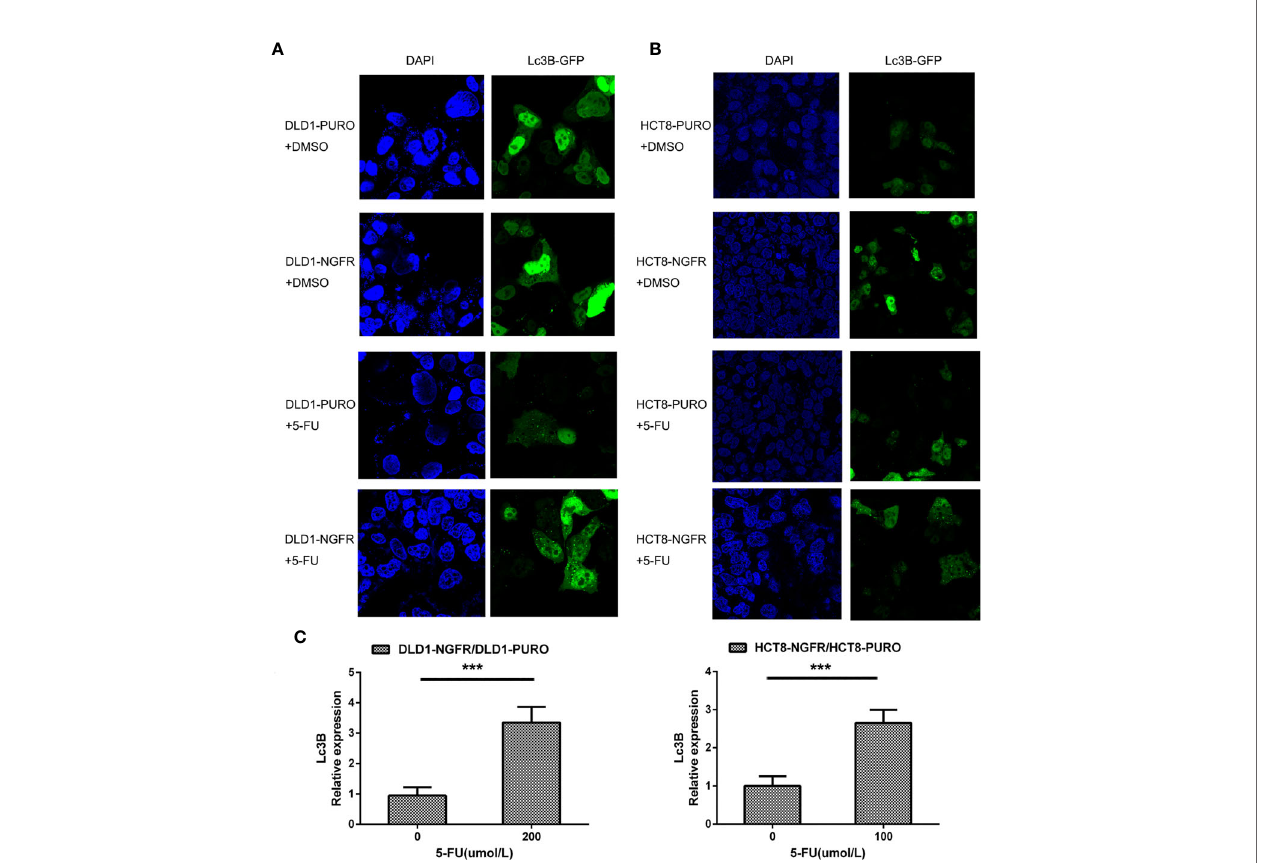
FIGURE 3 | NGFR promoted 5-FU-induced autophagy of CRC cells. Overexpressed NGFR – transfected DLD1 and HCT8 cells were treated with 5-FU for 48 h. The cellular autophagy induced by (A) 200 µ M of 5-FU for DLD1 and (B) 100 µ M for HCT8 cells was examined by confocal microscopy with transfection with a GFP-LC3B vector. (C) Autophagosome-expressing LC3B (green dot) was quantitated in overexpressed NGFR – transfected compared to empty vector – transfected DLD1 and HCT8 cells treated with 5-FU (t-test; ***P <